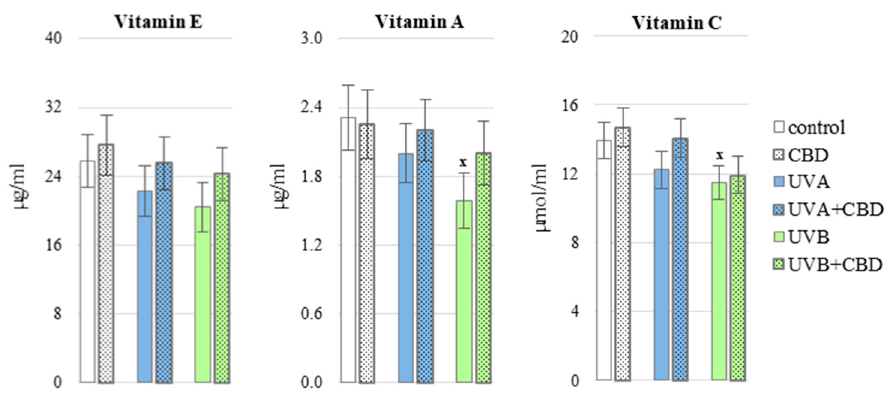
Figure 5. The level of vitamins E, A, C in the blood plasma of nude rats in the following groups: control; treated with CBD (every 12 h) for 4 weeks; irradiated with UVA (every 48 h) for 4 weeks; irradiated with UVA (every 48 h) and treated with CBD (every 12 h) for 4 weeks; irradiated with UVB (every 48 h) for 4 weeks; irradiated with UVB (every 48 h) and treated with CBD (every 12 h) for 4 weeks. The mean values for six rats in each group ± SD are shown: x—differences vs. control group, p < 0.05.